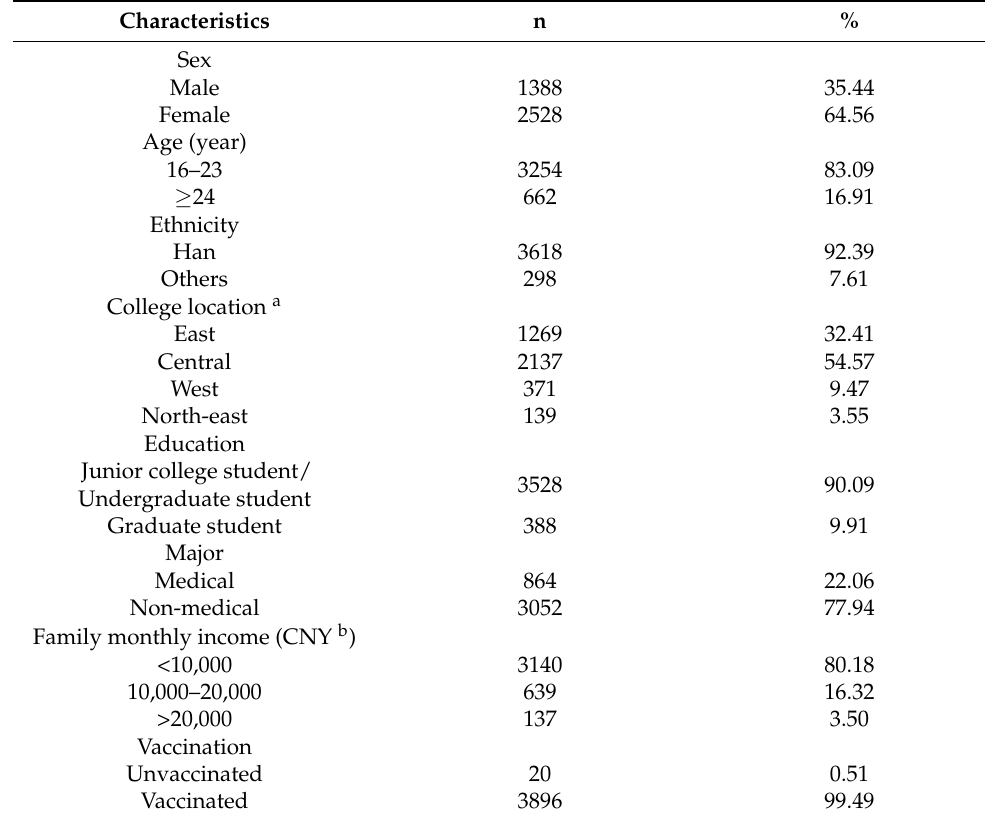
Figure 2. Reasons for not receiving the COVID-19 vaccine (%) among college students in China (N = 20).